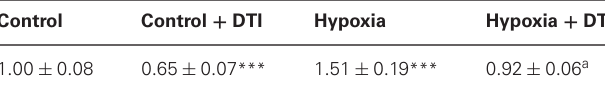
Table 1 | ROS levels in cultured brain endothelial